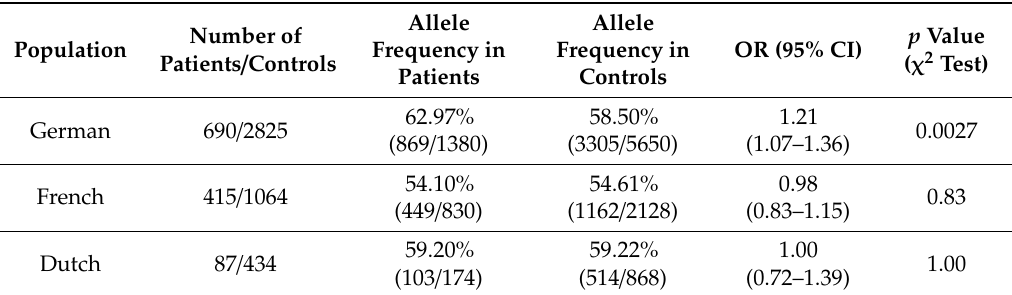
Table 2. Comparison of the rs10273639(C) allele frequencies in the NACP patients and controls in the context of each population studied by Derikx et al. [9].